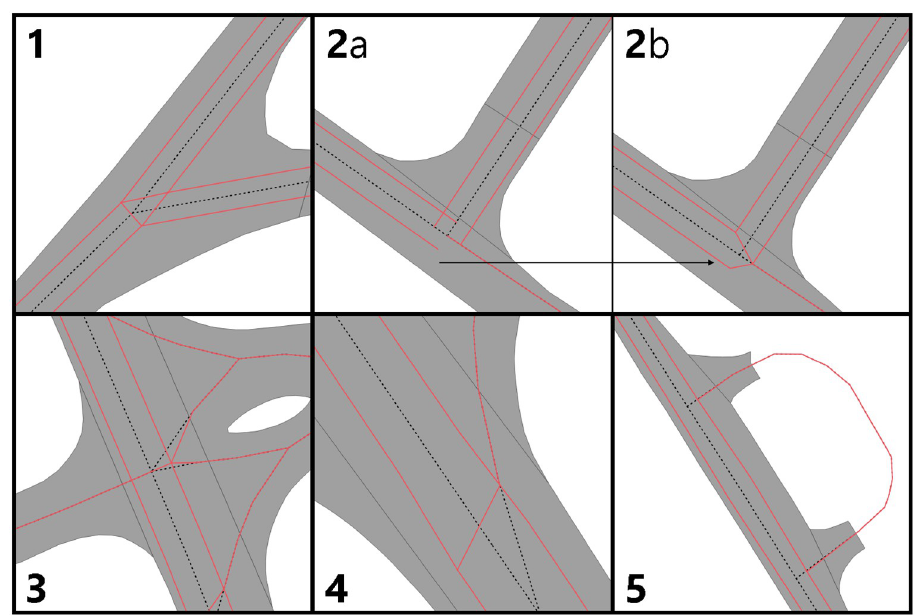
Fig 7. Five special cases that affected our methodology: (1) three dual carriageways with unclear continuations; (2) a three-way intersection where two dual carriageways meet a single but the duals are perpendicular; (3) a dual carriageway that is crossing an existing merging dual carriageway from OSM; (4) exit lane from a dual carriageway; and (5) small segment that crosses the same road in both ends.